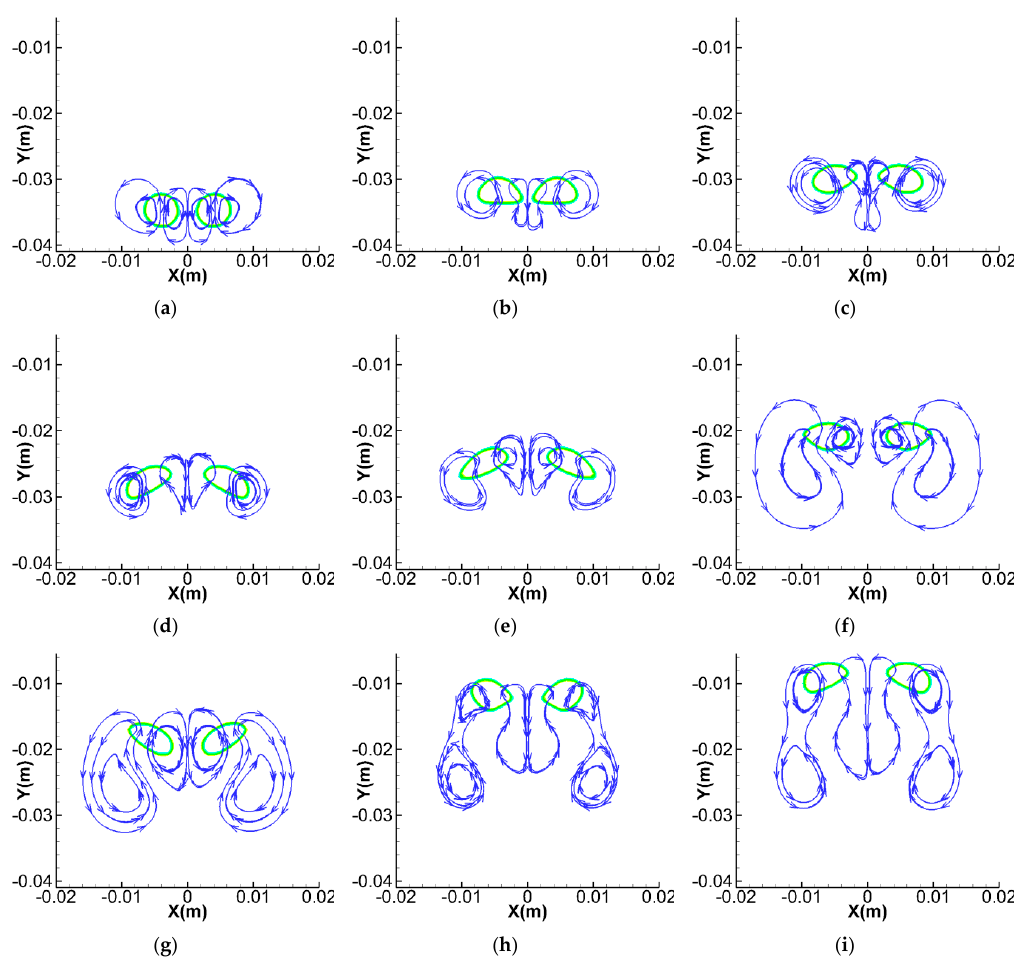
Figure 14. The Streamline shape and deformation process of two rising bubble. ( a ) t = 0.01 s; ( b ) t = 0.04 s; ( c ) t = 0.06 s; ( d ) t = 0.08 s; ( e ) t = 0.1 s; ( f ) t = 0.13 s; ( g ) t = 0.15 s; ( h ) t = 0.20 s; ( i ) t = 0.22 s. At the same time, the part of the two bubbles near the wall surface moved behind, were at the deeper water level position, and had greater pressure. Thus, the air here moved towards the low-pressure area (i.e., the position of the shallow water level) inside the bubbles. The shape and position of the two bubbles were in an approximately horizontal state after a period of time, as shown in Figure 14f. As a result of the movement of air in bubbles to the middle area and a smaller distance between the bubbles, the drop velocity of fluid in the middle became larger, and a low-pressure area formed. Thus, the two bubbles noticeably attracted each other. As seen from Figure 15e, when the two bubbles left, the liquid membrane thickened; when the two bubbles approached again, they entered the liquid membrane region and the liquid membrane fluid flowed downward to the inside. The bubbles were distributed in a “V” shape when they approached each other (Figure 14g).